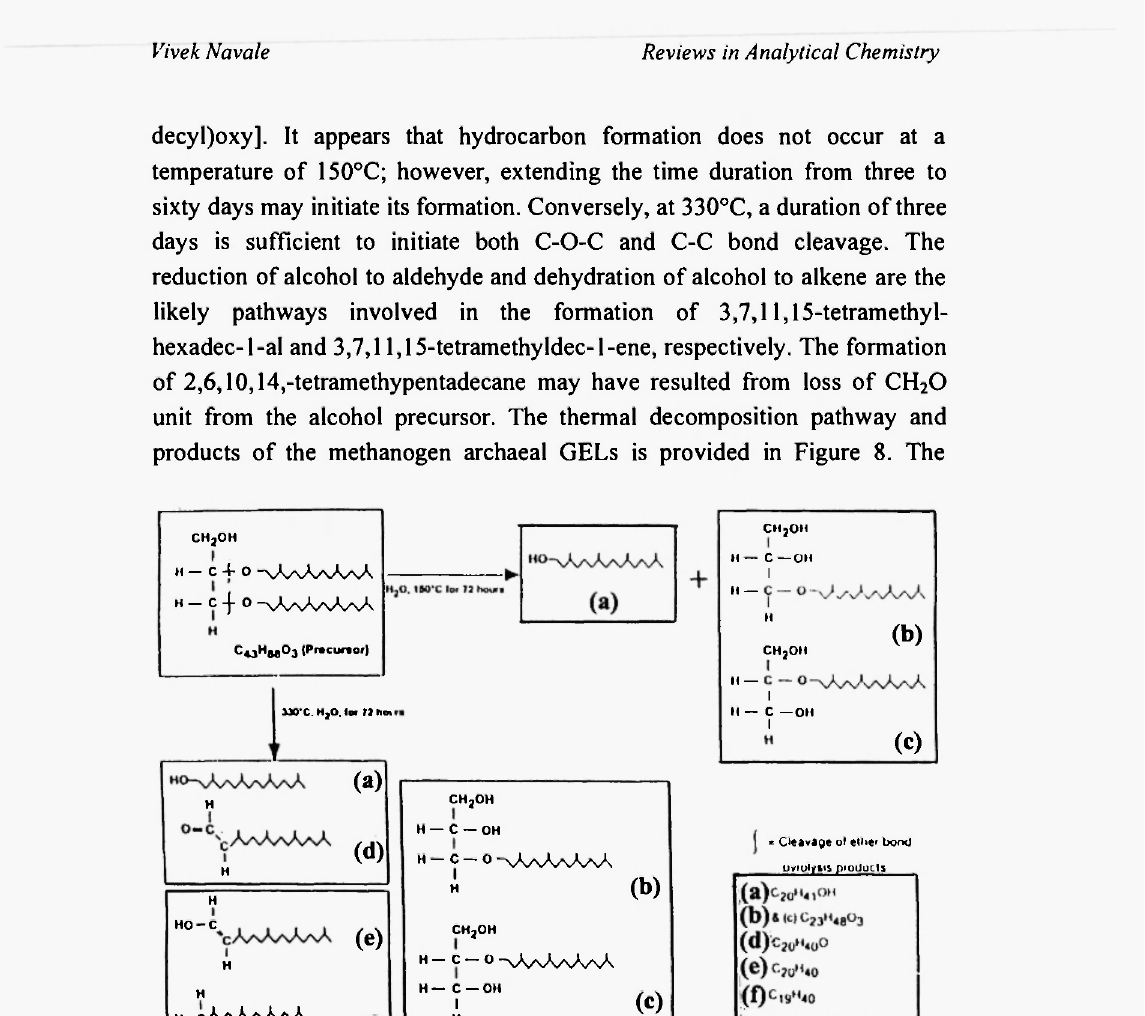
Fig. 8: Schematic representation of thermal decomposition pathway, and the products formed by hydrous pyrolysis of archaeal glycerol ether lipids at 330 and 150 °C for time duration of three days, each. The pyrolysis